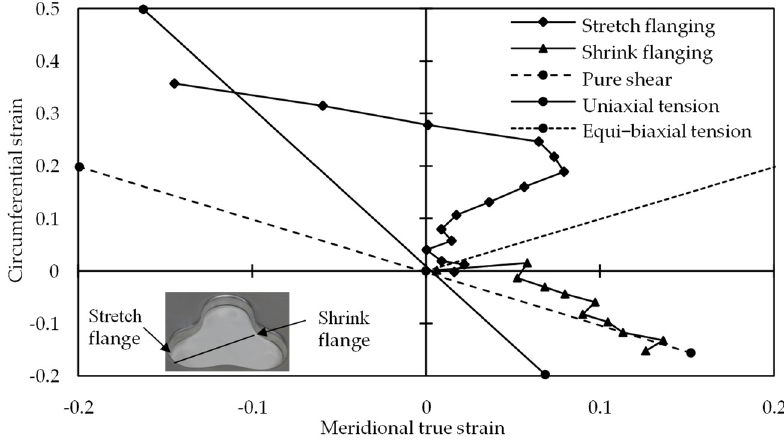
Figure 9. Strain evolutions on X-axis cross-section (reprinted with permission from Zhang et al. [40], Copyright 2018